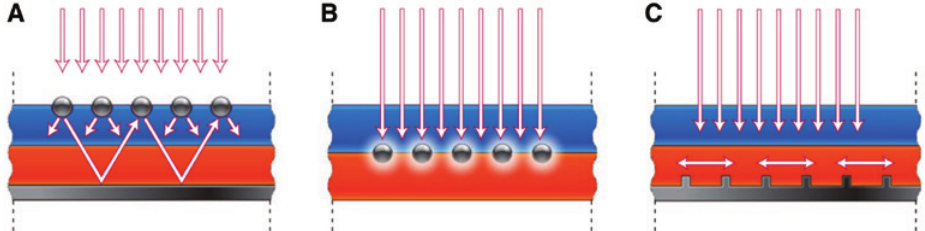
Figure 15: Schematic diagram of plasma capture light for a thin-film solar cells. (A) Using the metal nanostructure scattering characteristics to achieve the purpose of light capture. (B) Metal nanoparticles embedded in the semiconductor for producing local surface plasmas to capture light. (C) Incident light is irradiated onto the metal surface to produce an SP polarization effect that promotes light absorption